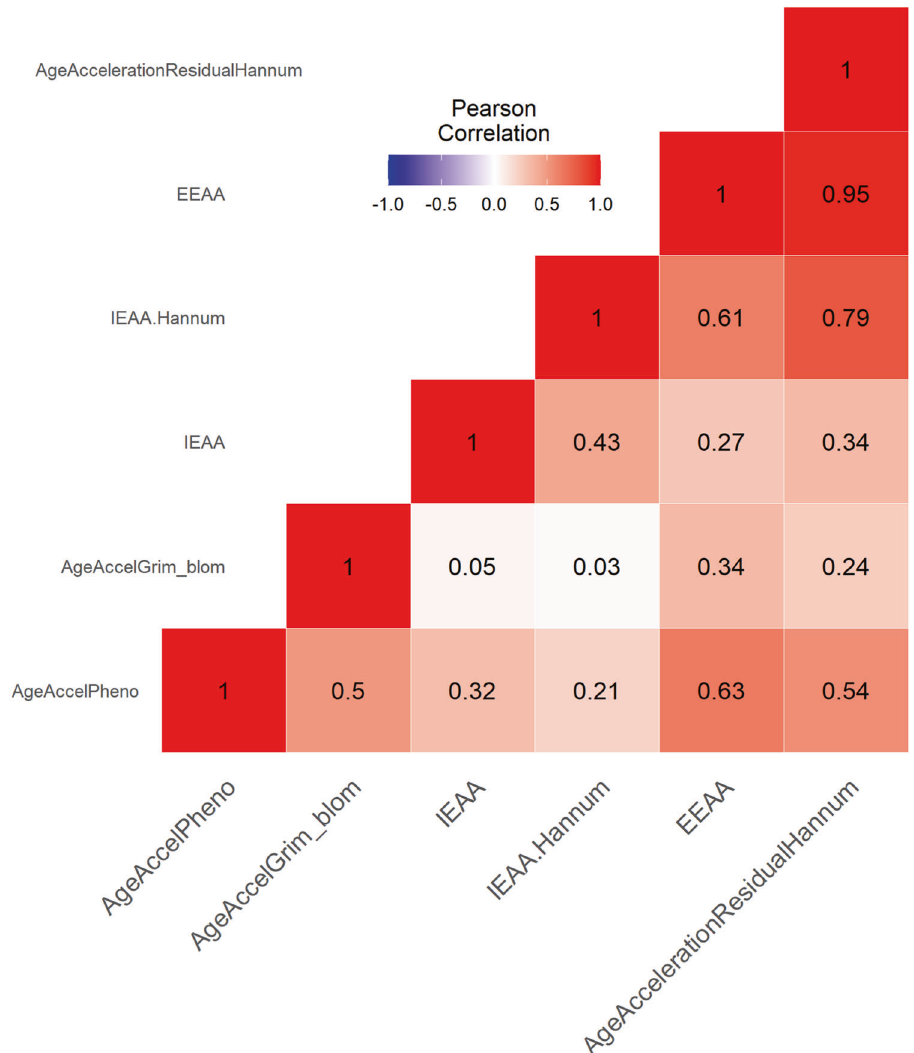
correlated of medium strength with the acceleration of Horvath and Hannum state-of-the-art algorithm GrimAge, compared to chronological age in a sample of female EUPD patients in early adulthood. This highlights the need for both clinical attention and further research in this area. To develop effective interventions to prevent and alleviate negative health effects in EUPD, it is crucial to have a coherent model of the mechanisms underlying the association